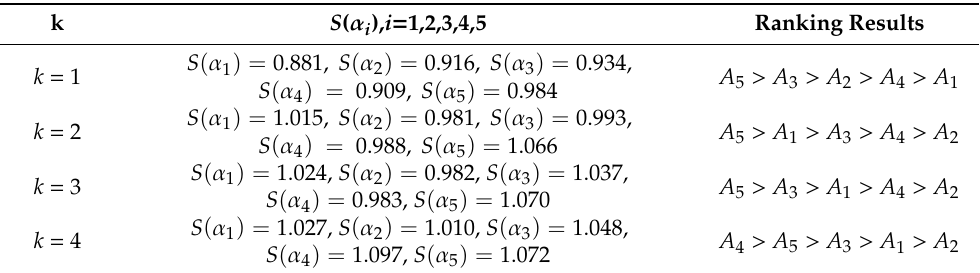
Table 7. Ranking results by using the di ff erent parameter k in the q -RPFDWDHM operator.